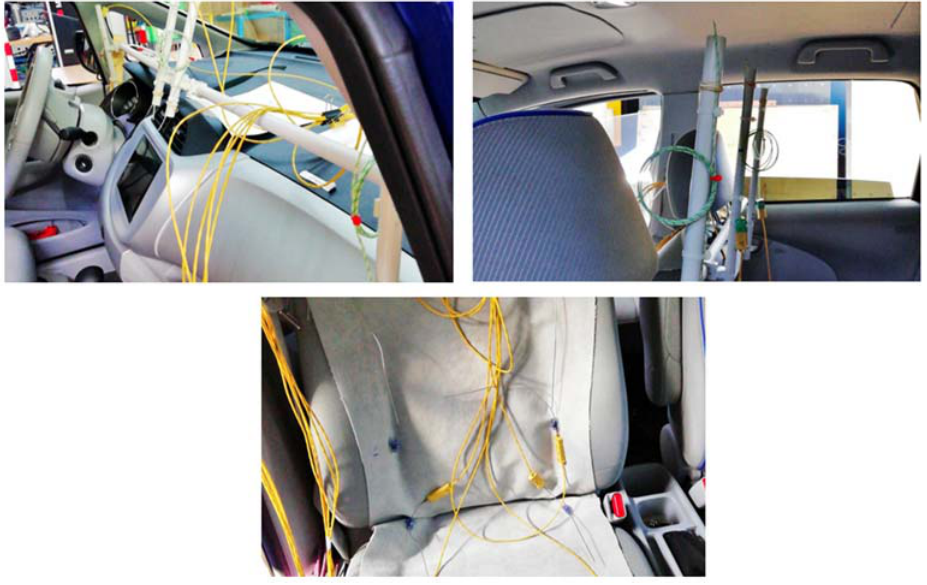
Figure 6. Cabin temperature sensors [18,23]. Image © European Union,